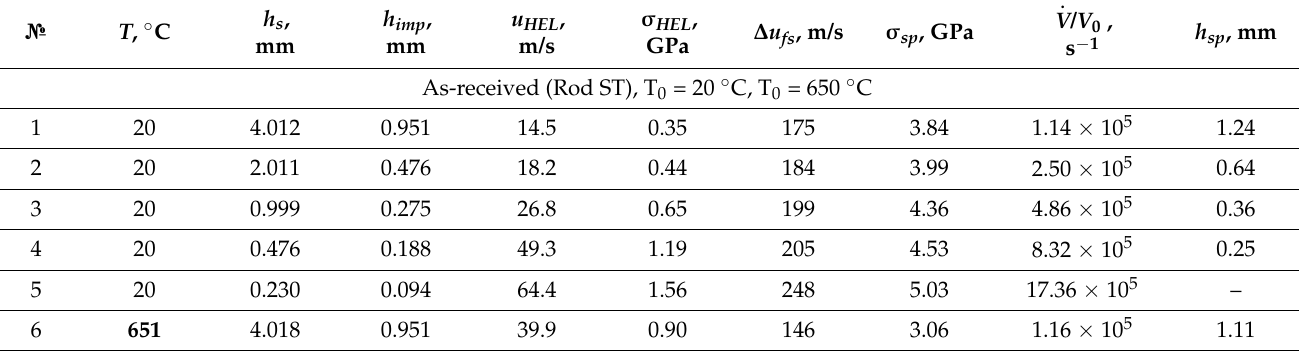
Table 3. The conditions of experiments with Inconel 718 superalloy samples after various heat treatments at 20 ◦ C and 650 ◦ C and the results of their